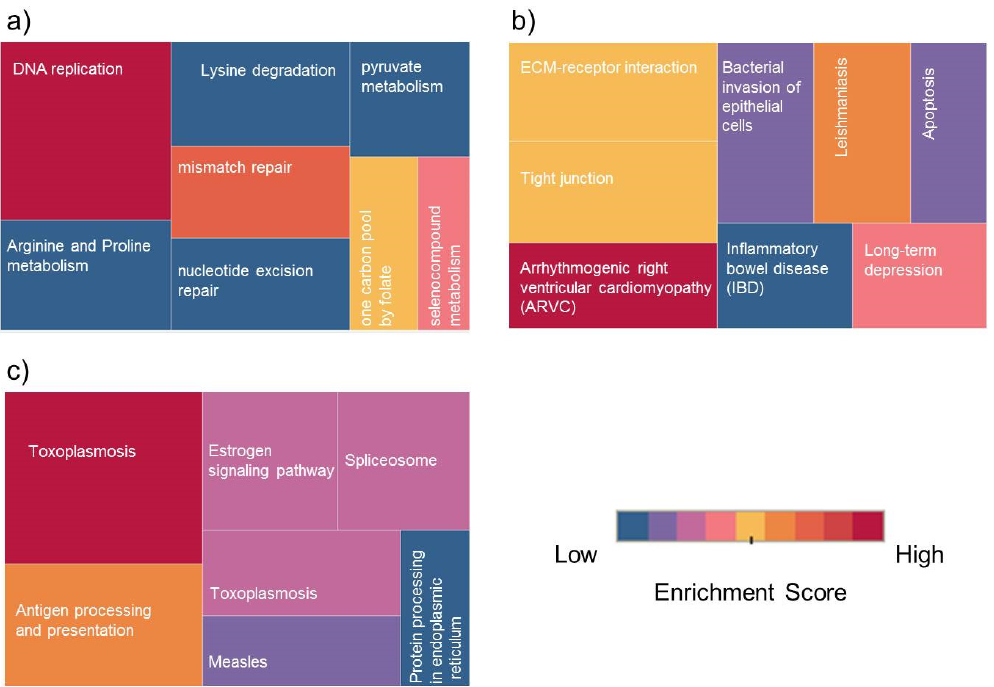
Figure 3. Treemap of Kyoto Encyclopedia of Genes and Genomes (KEGG) pathway classes for differentially expressed proteins (DEPs): Top Enrichment pathway classes for ( a ) upregulated proteins in KAIMRC1 versus MCF-7, ( b ) downregulated proteins in KAIMRC1 versus MCF-7, and ( c ) upregulated phosphoproteins in KAIMRC1 versus MCF-7 and MDA-MB-231. The color and size of each box indicate enrichment score and protein counts for each group. The enrichment analysis was set with statistical criteria ( p < 0.05).